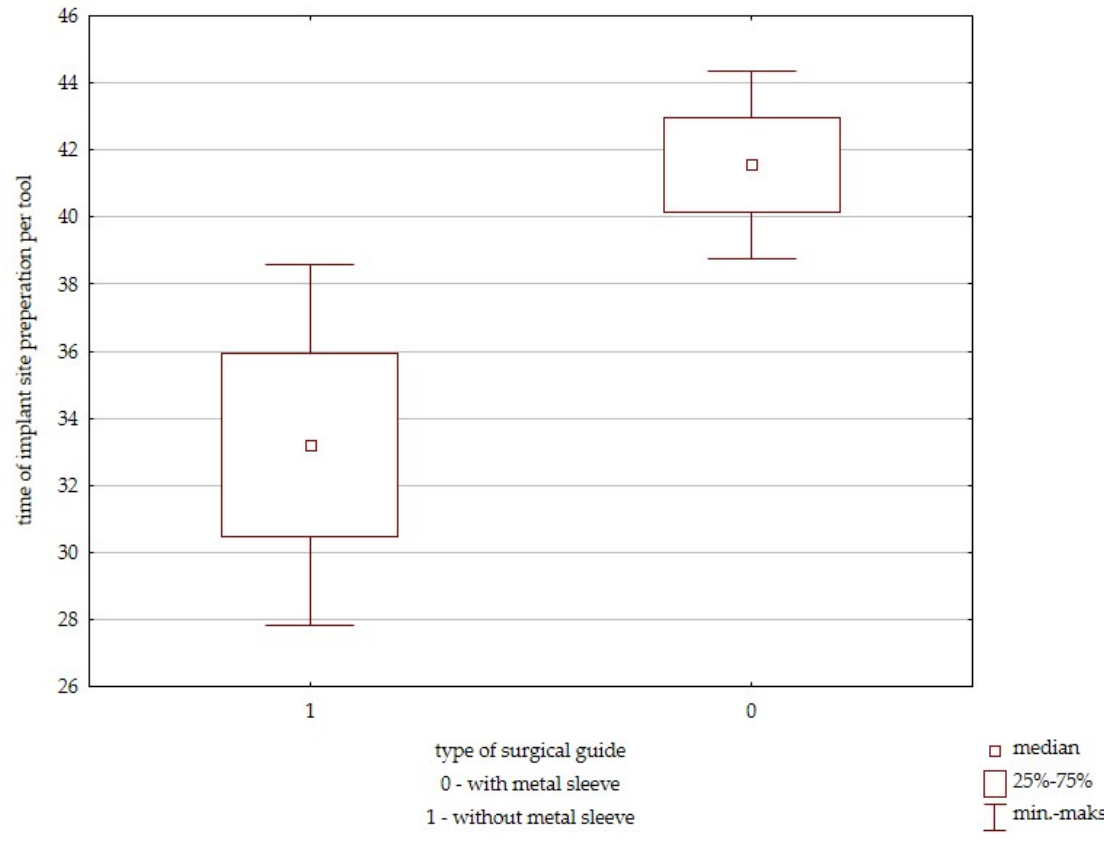
Figure 2. Comparison of time of implant site preparation per tool depending on the type of surgical guide: group 0, without metal sleeves, OGK; group 1, with metal sleeves, GKT. Analysis of the boxplots demonstrated a statistically significant difference between the groups. Post hoc power calculation was performed to evaluate the statistical power of the study. Given the endpoint means and number of subjects, with alpha set to 0.05, the post hoc power was 100% (Figure 3).